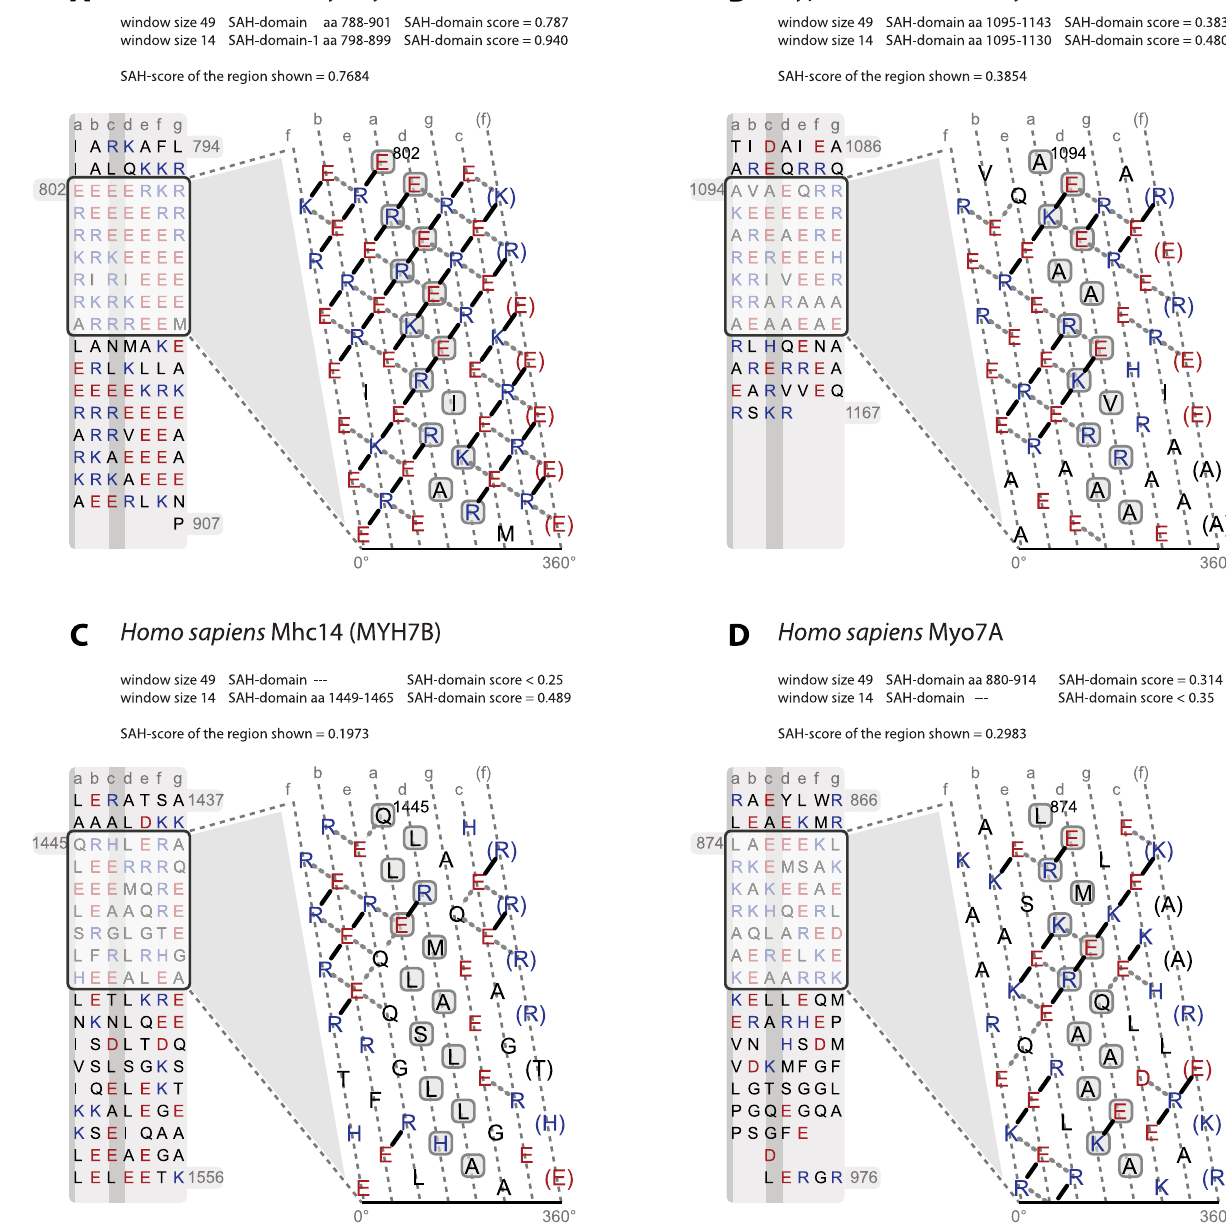
PLOS ONE | https://doi.org/10.1371/journal.pone.0177716 May 11,